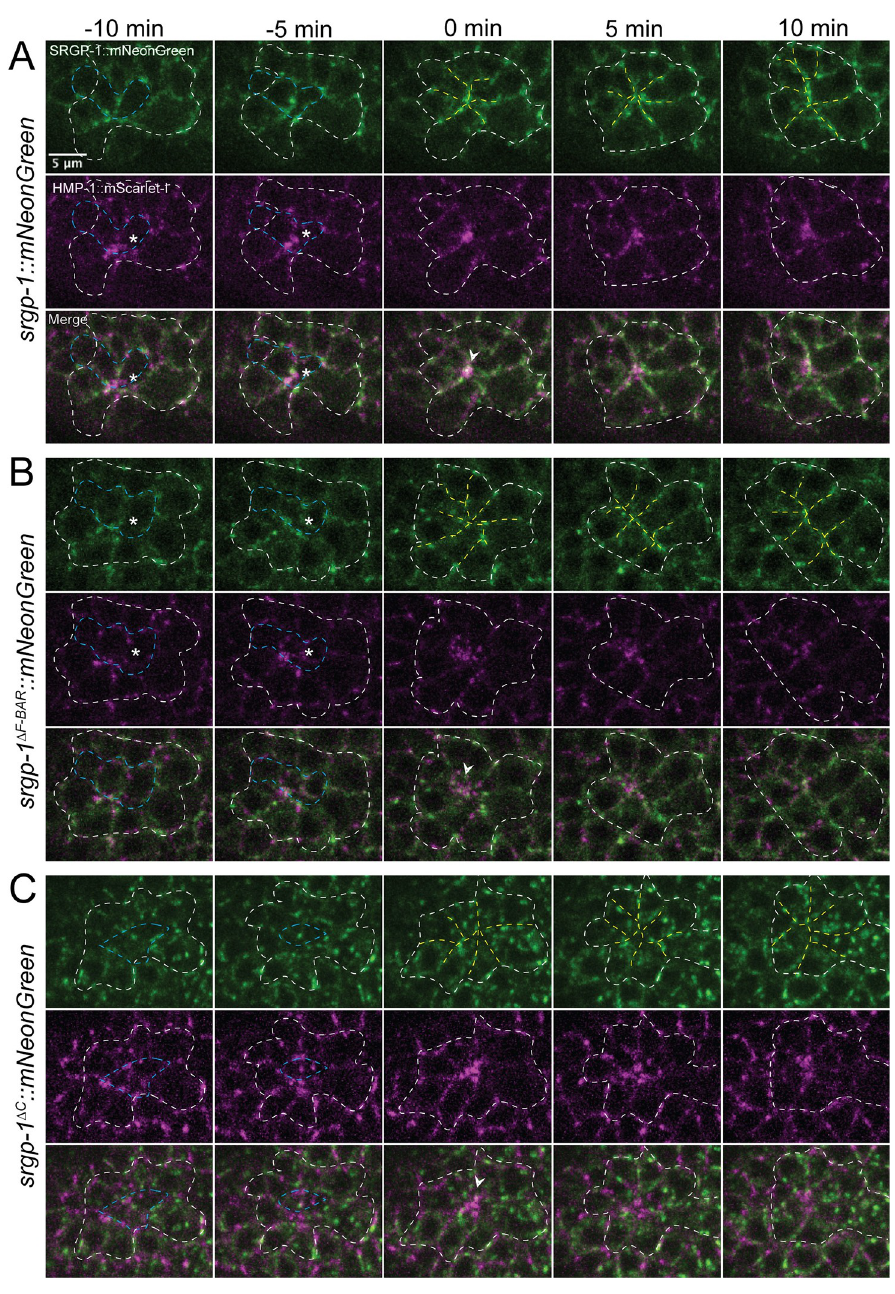
Fig 3. srgp-1 mutants display aberrant HMP-1::mScarlet-I aggregation and anterior rosette formation. Representative embryos expressing full-length or deleted SRGP-1::mNeonGreen, as well as HMP-1::mScarlet-I. ( A ) SRGP-1::mNeonGreen; ( B ) SRGP-1 Δ F-BAR ::mNeonGreen; (C) SRGP-1 Δ C ::mNeonGreen. Blue dotted lines indicate cell internalization that precedes formation of rosettes. White arrowheads indicate the vertex of the rosette following cell internalization. White dotted lines outline cells that contribute to the rosette; yellow dotted lines depict cells arranged around the vertex of the rosette. Scale bar is 5 μ